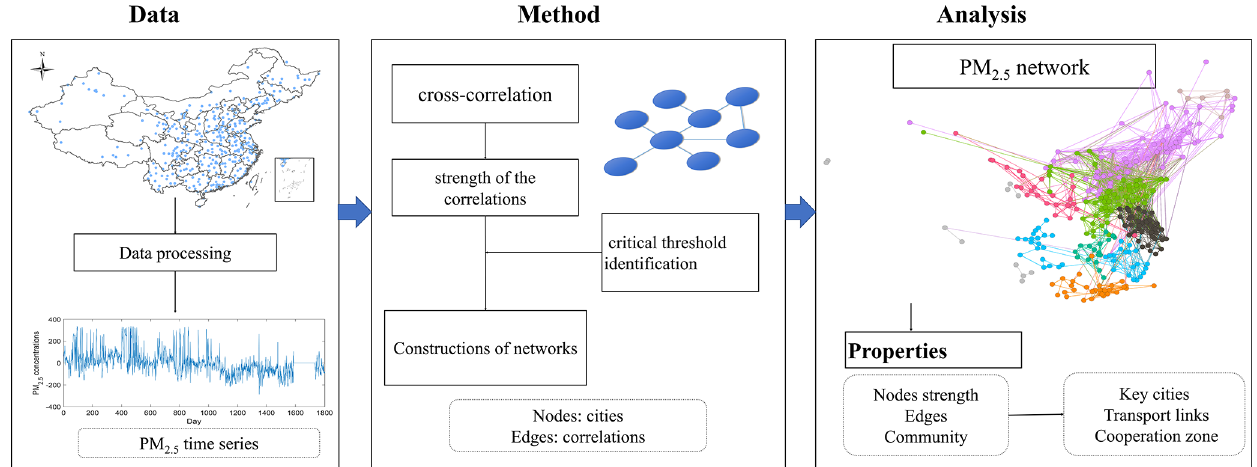
Figure 1. The flow chart of the method with complex network analysis. Please note that the above figure contains disputed territories.